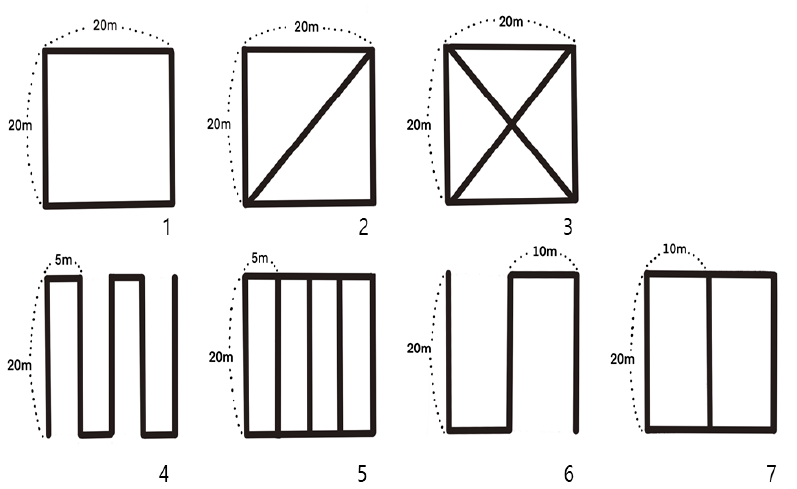
Figure 3. Survey paths used for scans with backpack personal laser scanning (BPLS) device. Walking along the plotline (pattern 1), a diagonal path added to pattern 1 (pattern 2), two diagonal lines added to pattern 1 (pattern 3), walking back and forth along straight lines at the interval of 5 m (pattern 4), a combination of pattern 1 and pattern 4 (pattern 5), walking back and forth along straight lines at the interval of 10 m (pattern 6), and a combination of pattern 1 and pattern 6 (7).